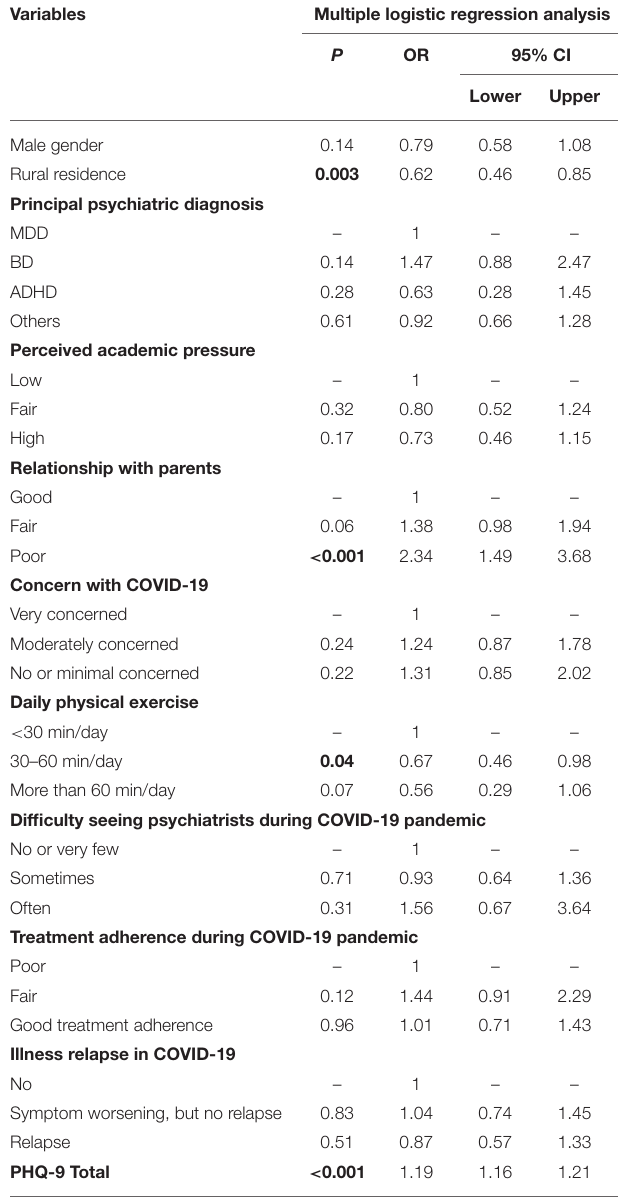
TABLE 2 | Independent correlates of IAD by multiple logistic regression analysis.